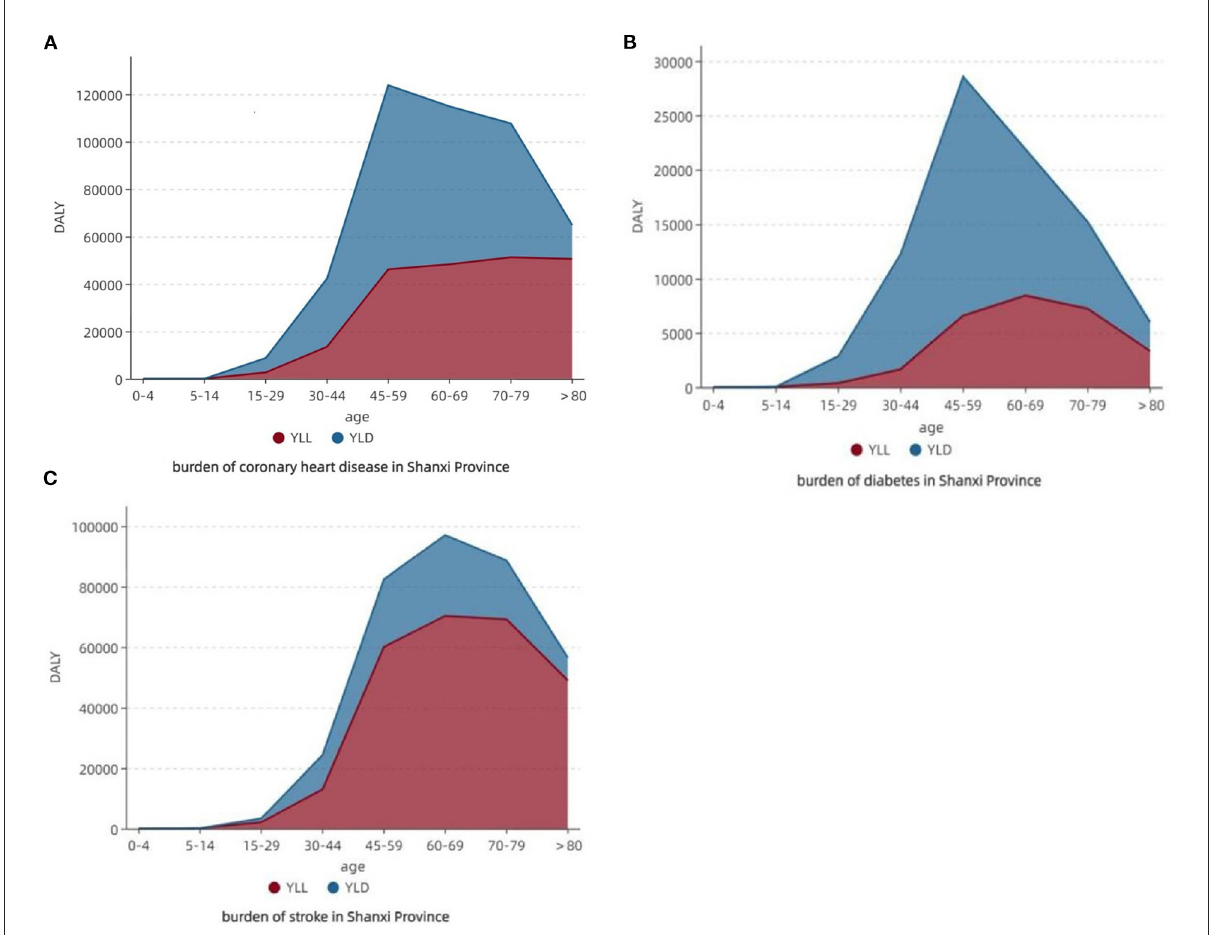
FIGURE2 Disease burden and composition of three chronic diseases.